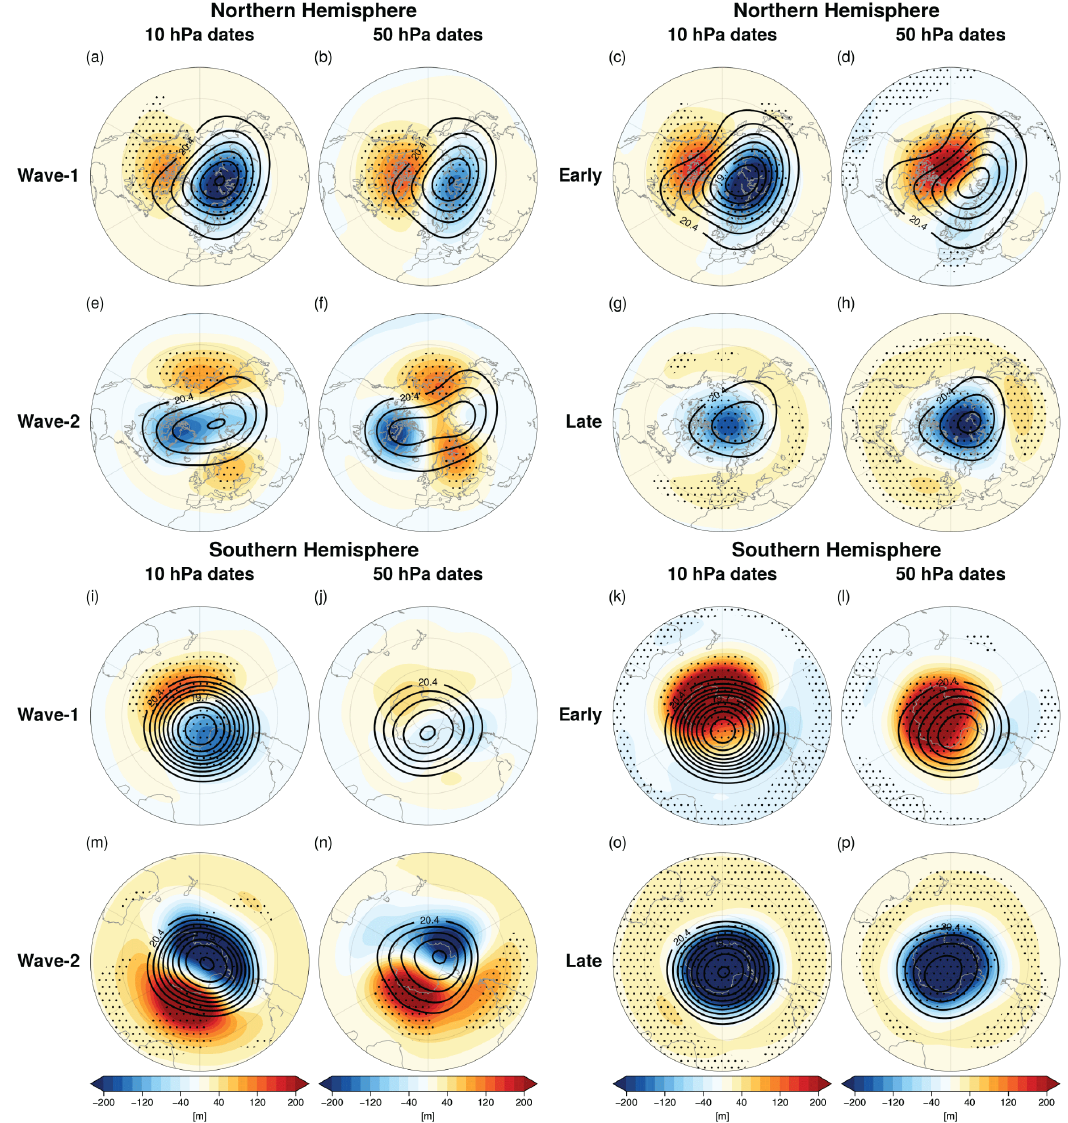
Figure 5. 50hPa geopotential heights (contours, [km]) and anomalies (shading; m) from JRA-55 reanalysis averaged over the 10d prior to the final warming at both 10 and 50hPa for (a–h) the NH and (i–p) the SH. Panels show the composites based on wave-1 or wave-2 classification, or early or late classification. Stippling indicates regions where the anomaly composites are significantly different from zero at the 95% confidence level according to a two-tailed t